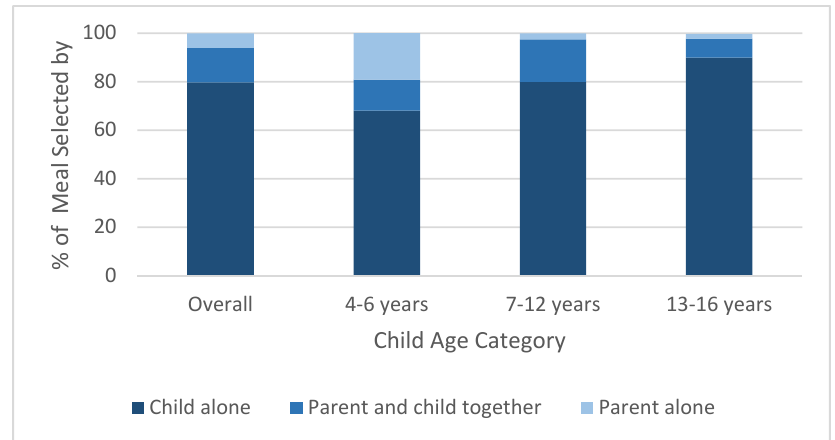
Figure 1. Ordering decisions by child age category inside of n = 4 quick service restaurants (QSRs) in New England.